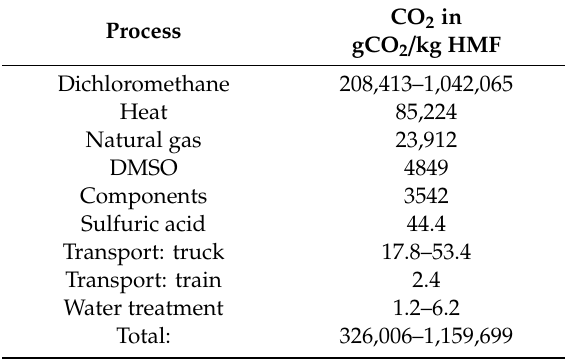
Table 4. CO 2 emissions during the production of HMF (according to the pilot process of the authors of [15]).